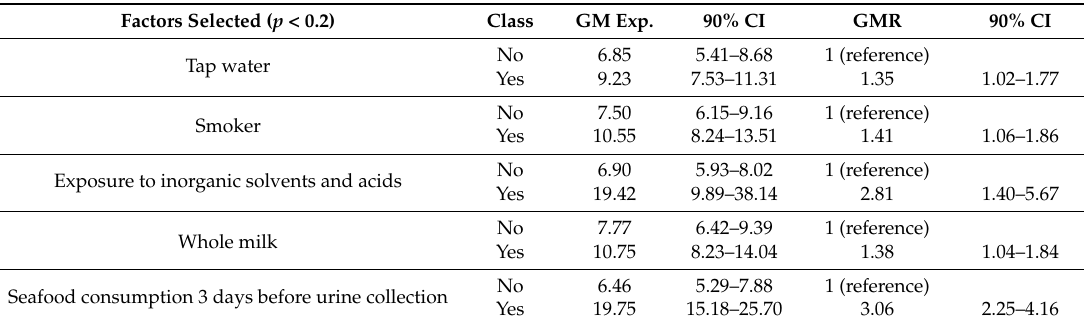
Table 5. Viterbese sample. Factors associated with u(iAs+MMA+DMA) concentration by stepwise multivariate